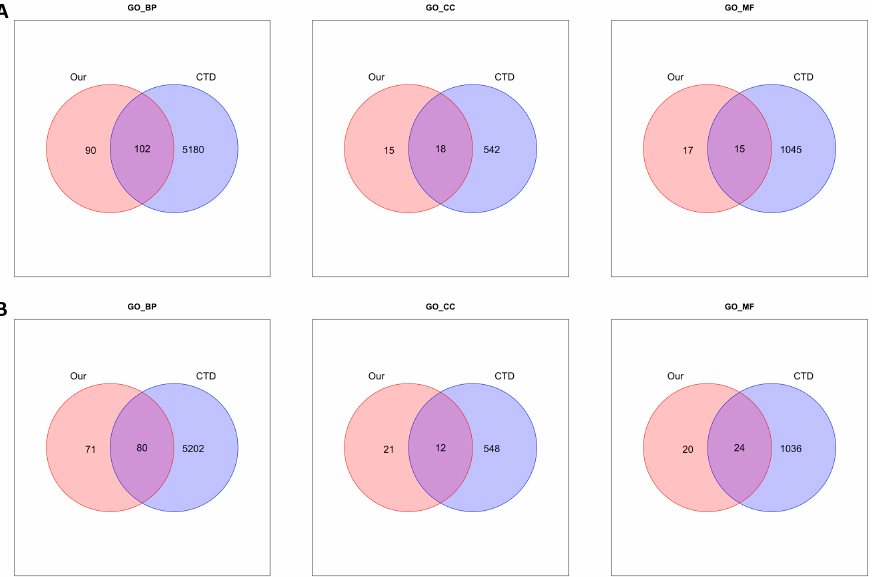
Figure 4. Venn diagrams showing GO_BP, GO_CC, and GO_MF of miRNAs. GO_BP: Biological processing; GO_CC: Cellular component; GO_MF: Molecular function of Gene Ontology; ( A ) BCMT-T vs. BCMT-N; ( B ) MCMT-T vs. MCMT-N.